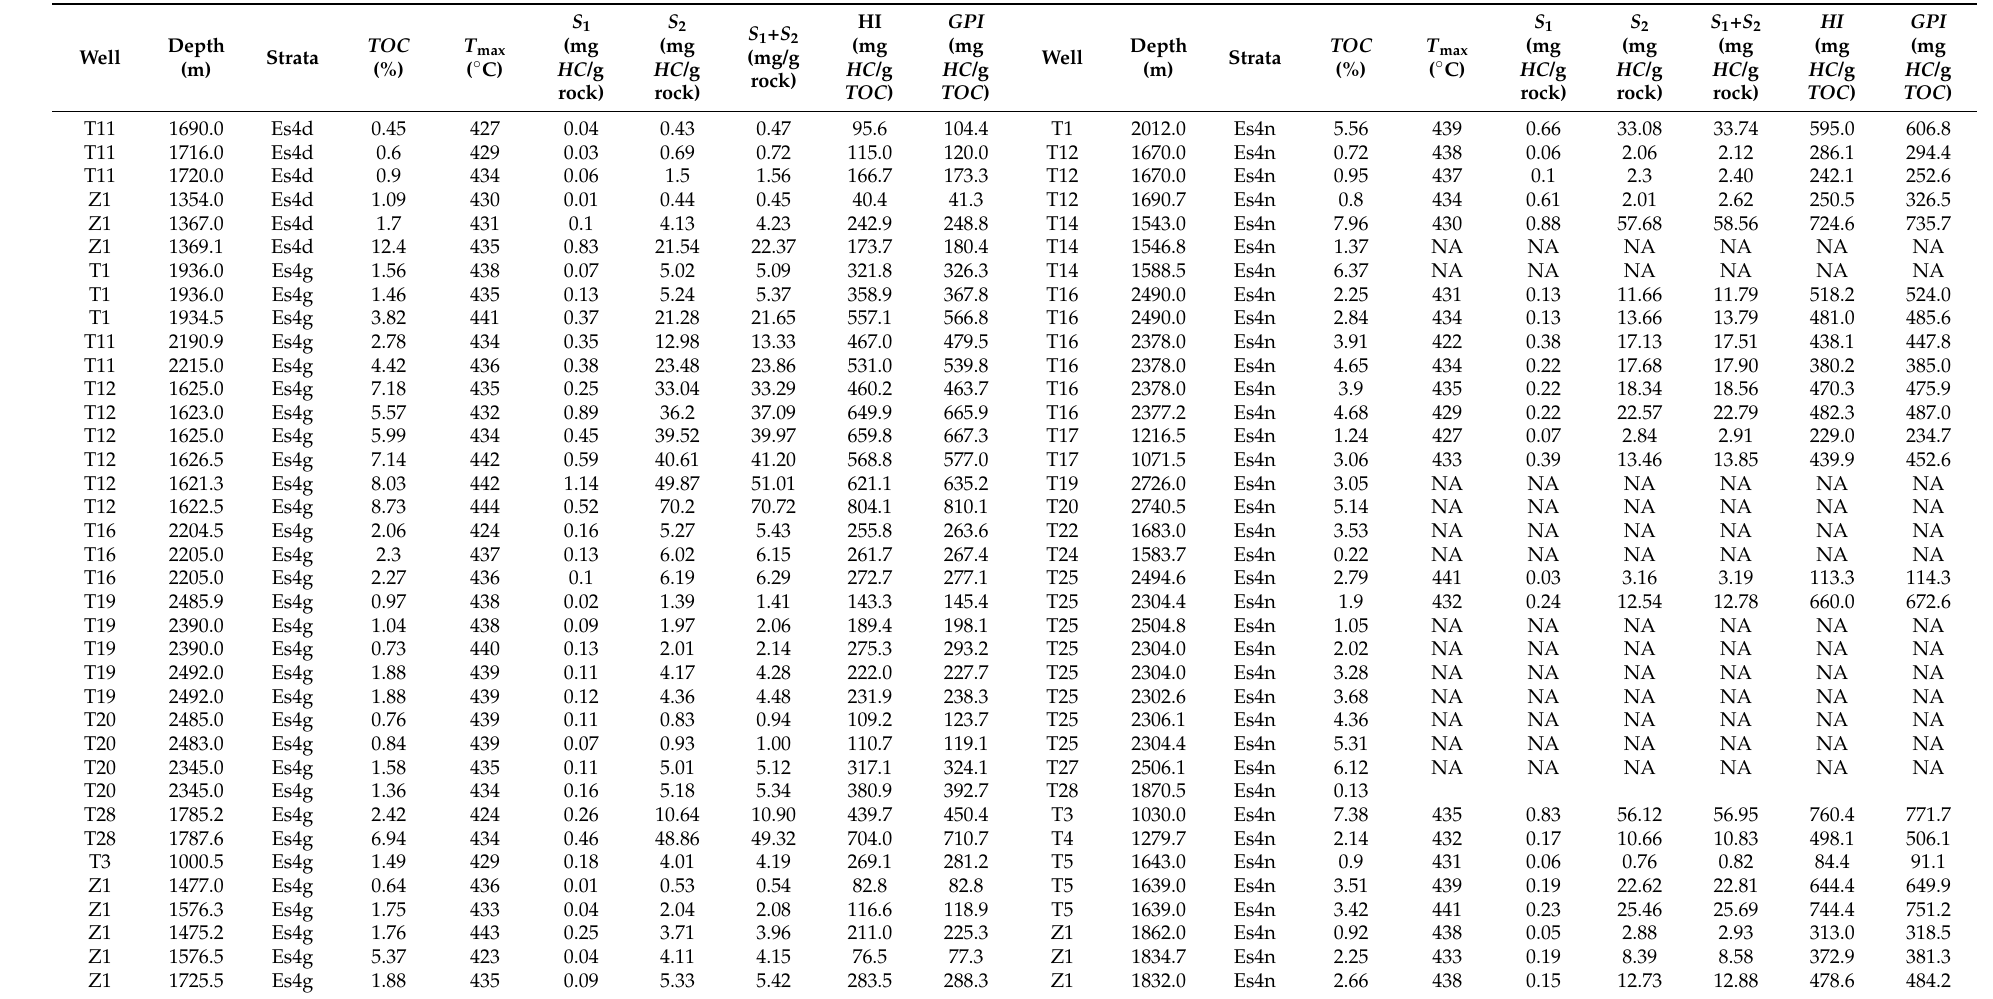
Table 1. Rock-Eval pyrolysis data used in the study